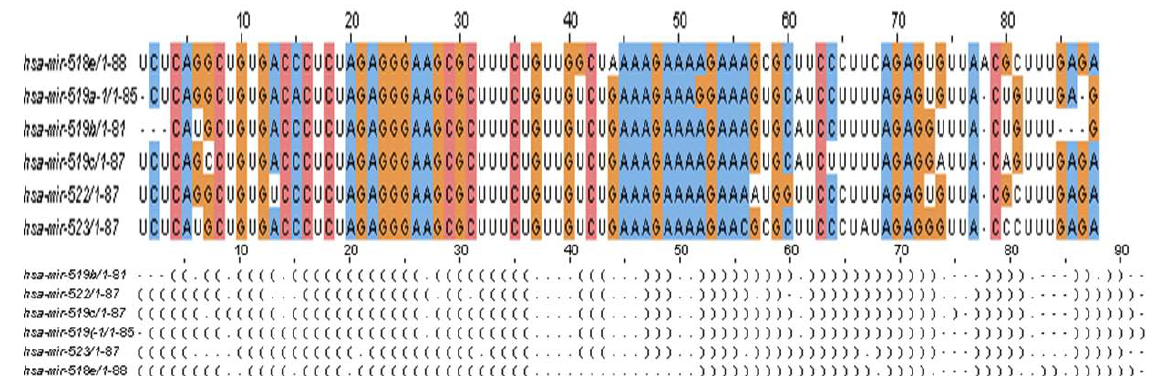
Figure 4: Multiple sequence alignment, performed by ClustalW [31] and visualized by JalView [32] , of six miRBase entries which lead to the same mature miRNA. The structural alignment below shows that although the sequence alignment is highly conserved, the structures are still quite different with hsa-mir-518 being the most